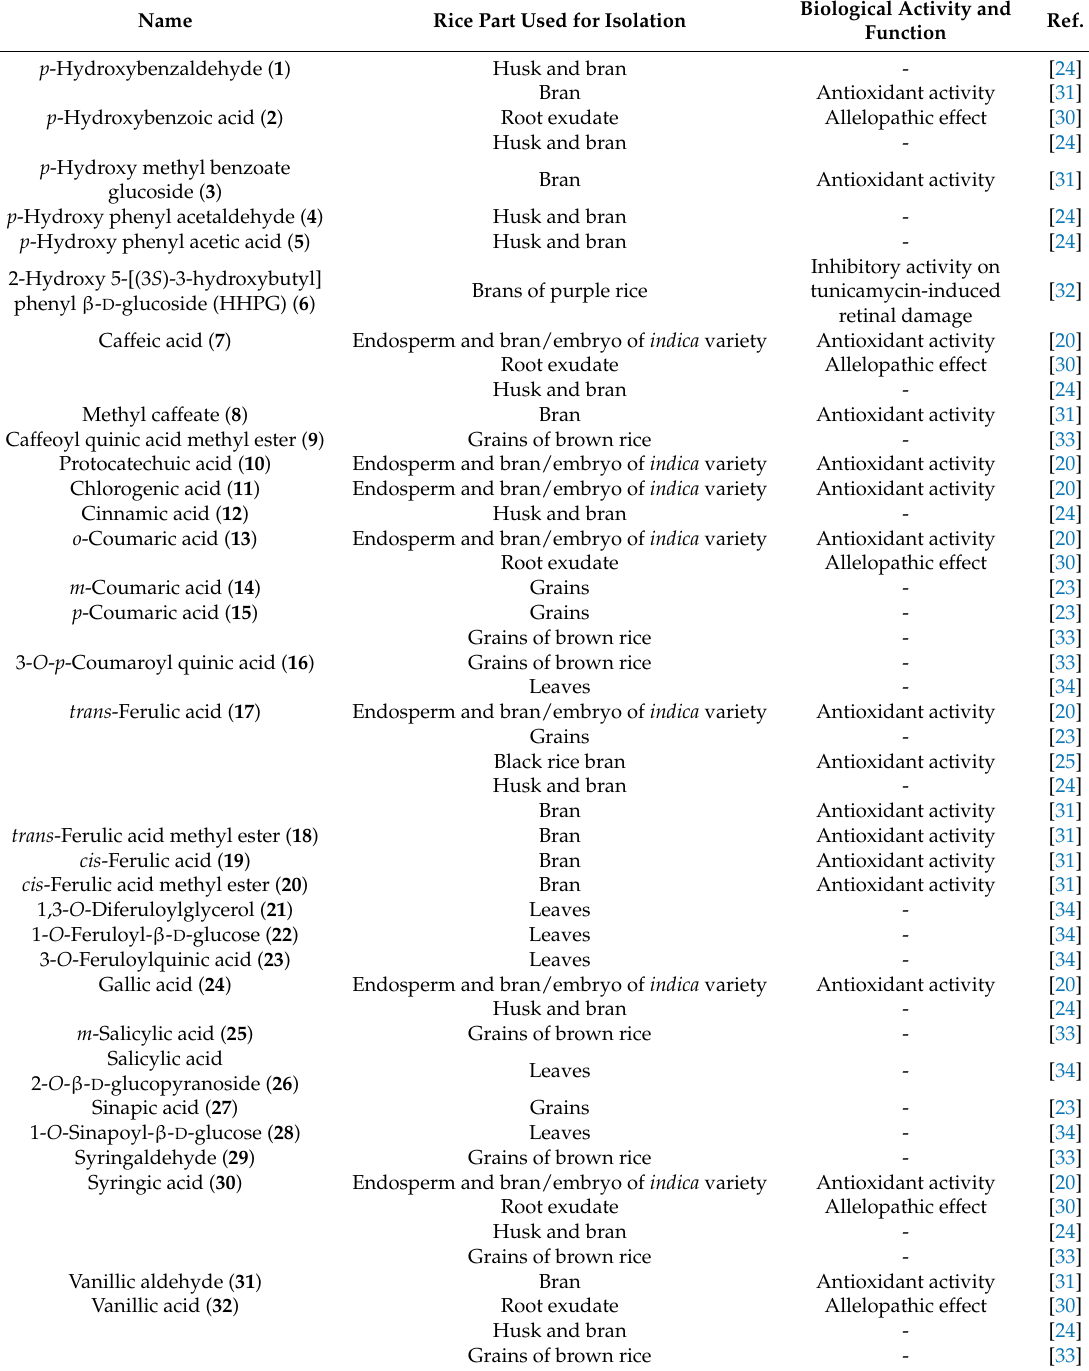
Table 1. Phenolic acids and their biological